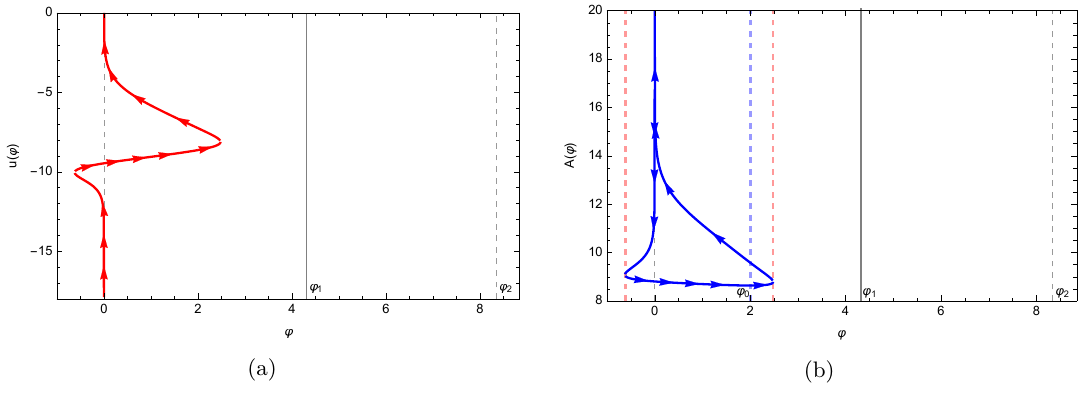
Figure 24 . (a): the holographic coordinate at top UV L boundary tends to −∞ and for bottom UV L to + ∞ . (b): the scale factor has an A-bounce at ϕ = 2 . 0 , the blue dashed line. The first ϕ -bounce on the left occurs at ϕ = − 0 . 62 and the second one at ϕ = 2 . 48 , the red dashed